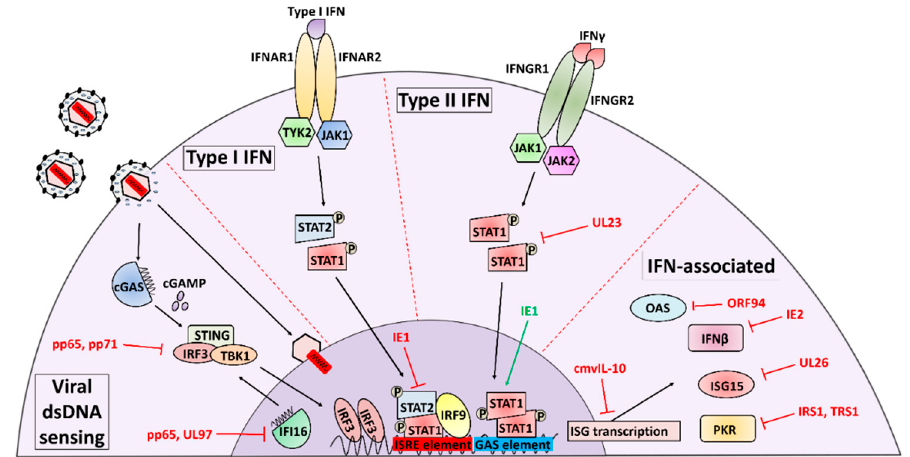
Figure 1. HCMV-mediated modulation of Interferon signaling.